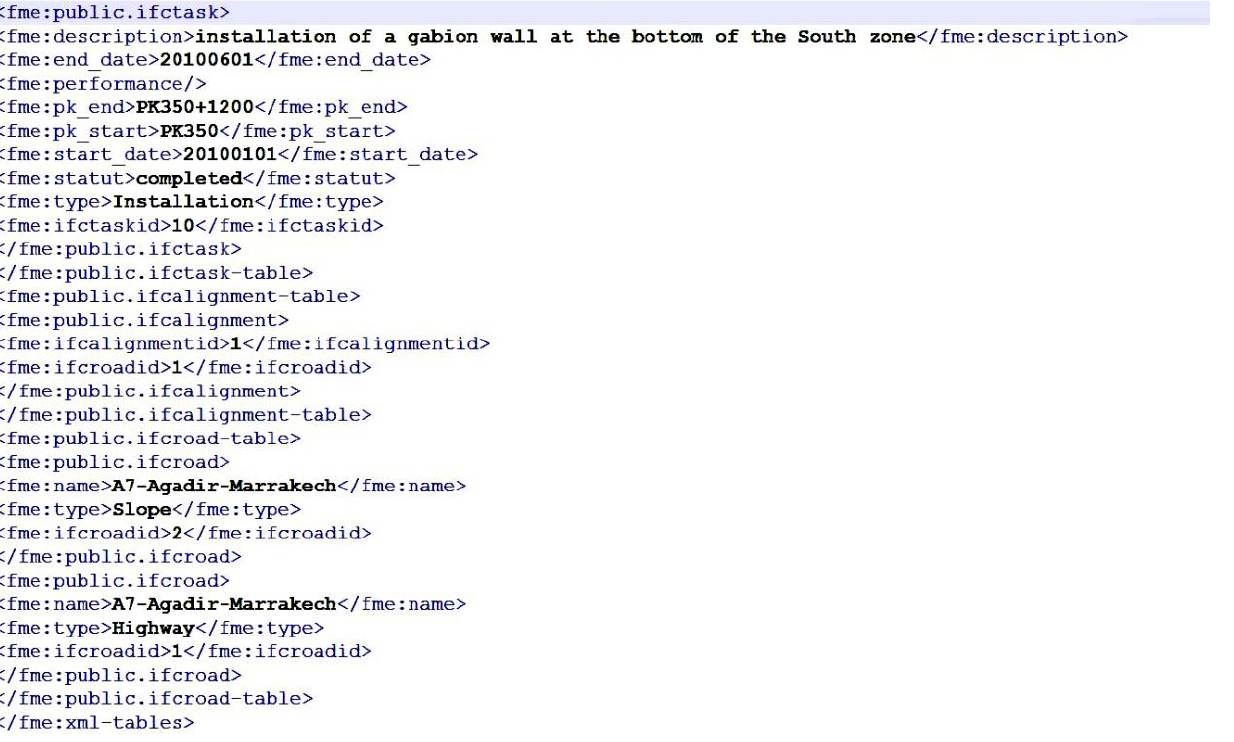
Figure 8. XML extract from the IFC model based on the IFC extension.